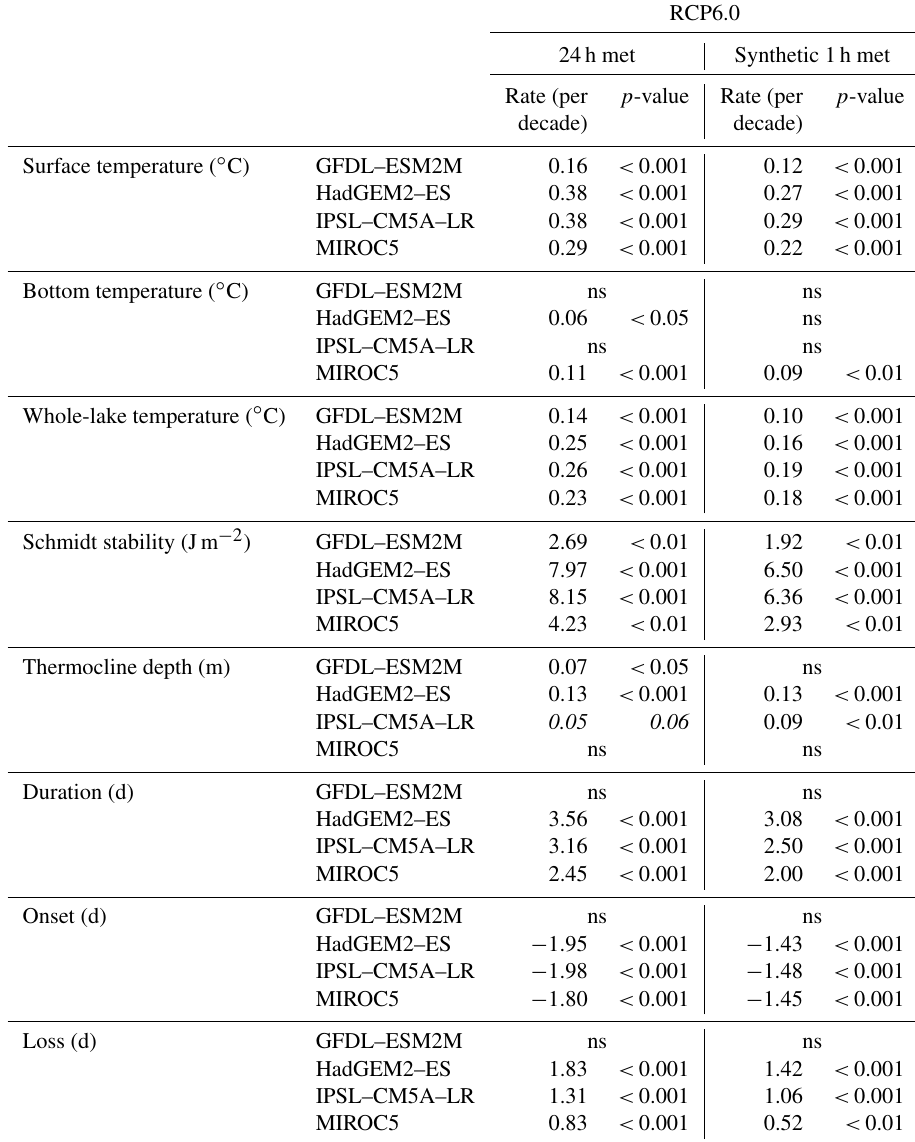
Table 5. Trend analysis from 2011–2100 for surface temperature, bottom temperature, whole-lake temperature, Schmidt stability, thermocline depth, duration, and onset an d loss of stratification (ns: not significant) for RCP6.0. Italics denote trends with p -value >